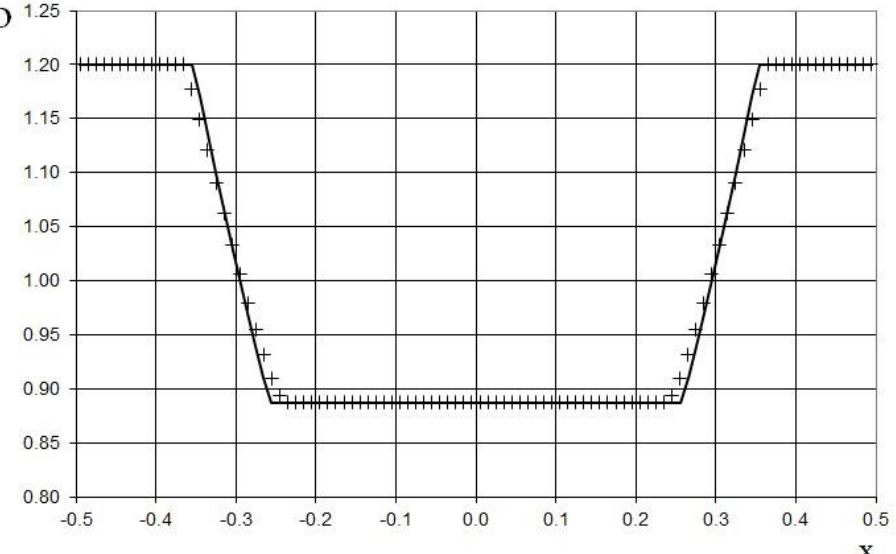
Figure 17. Density plot for the double expansion wave problem (47) for the one-dimensional scalar hyperbolic conservation law, using the coarse grid (100 grid points): the exact solution (line), and the present method (cross).